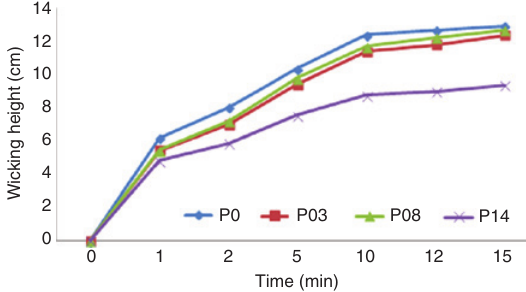
Figure 6: Vertical wicking of the polypropylene